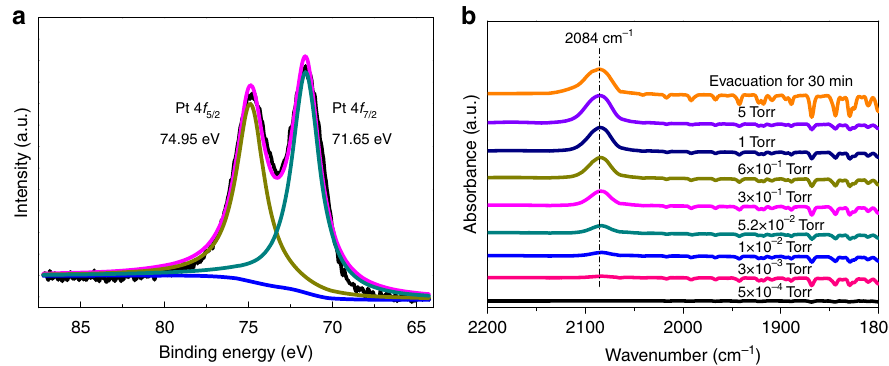
Fig. 3 X-ray photoelectron spectra and CO adsorption of Pt 1 (0) atoms. a X-ray photoelectron spectra of 0.5 wt% Pt 1 @PDMS-PEG/SiO 2 , and b In situ diffuse re fl ectance infrared Fourier-transform (DRIFT) spectroscopy of CO adsorption on 1 wt% Pt 1 @PDMS-PEG/SiO